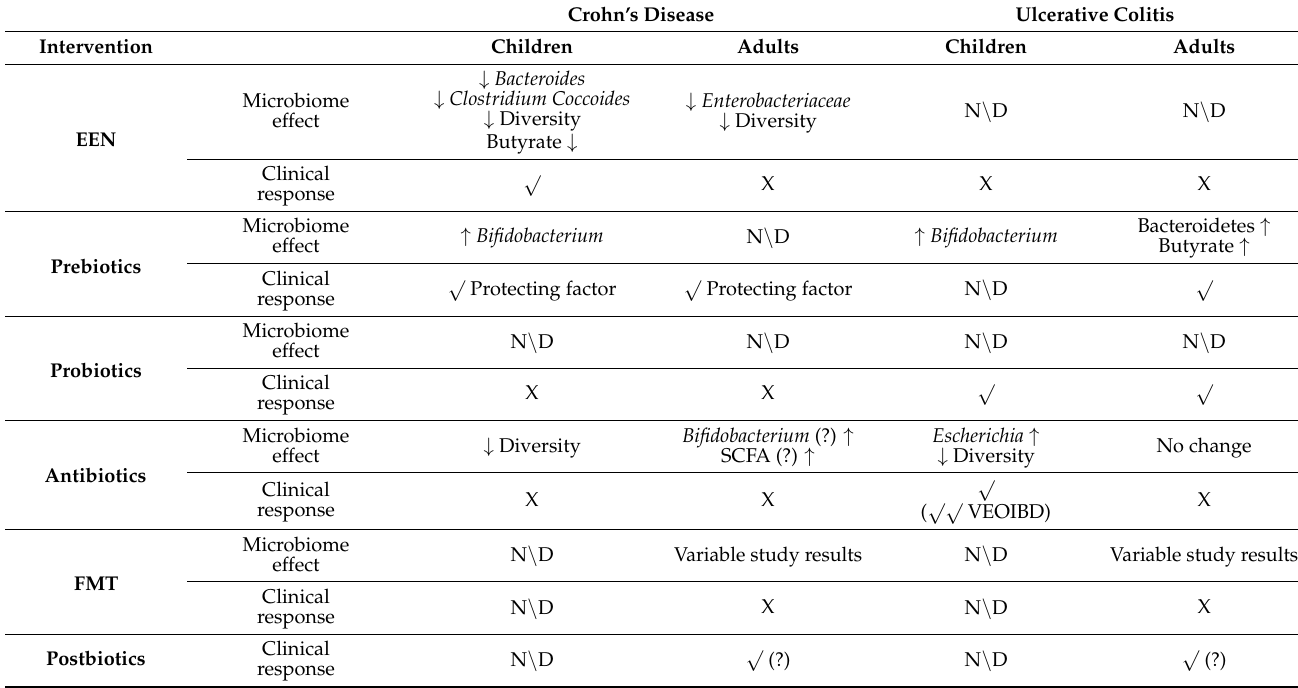
Table 3. Summary of the microbiome and clinical effects of the different microbiome modulation strategies discussed in this